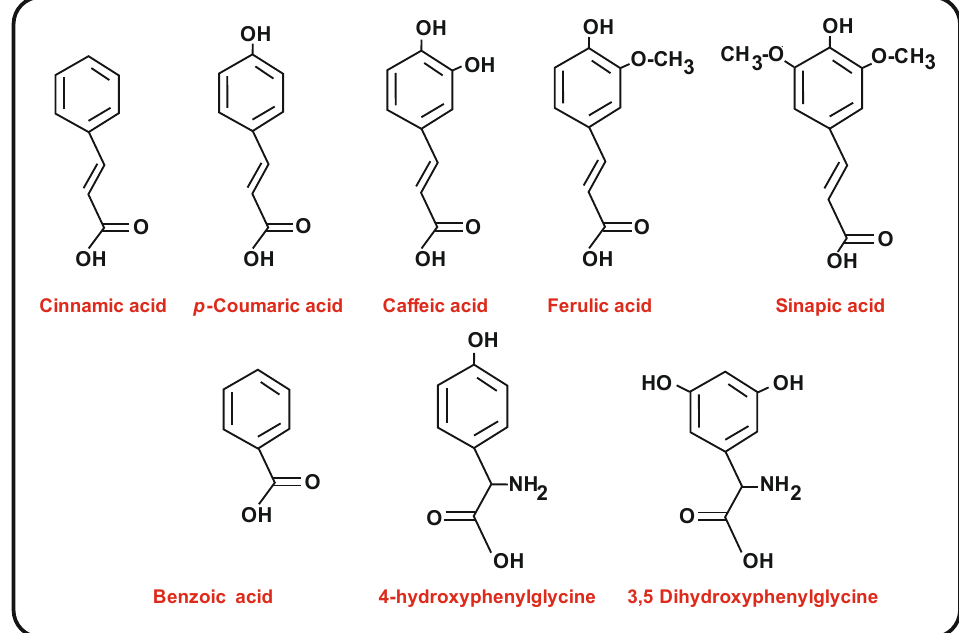
Figure 1. Aromatic acids and non-proteinogenic amino acids utilized by chalcone synthases (CHSs) as starter units in the phenylpropanoid pathway by different actinobacteria.